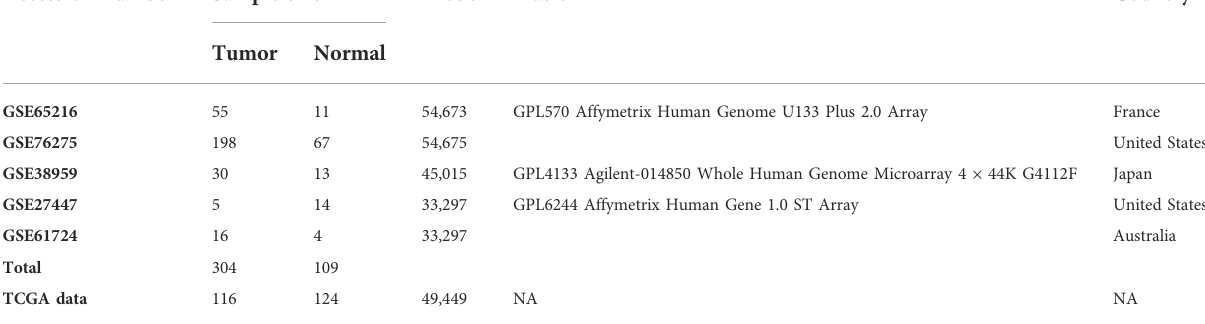
TABLE 1 List of datasets with brief descriptions that are used in this